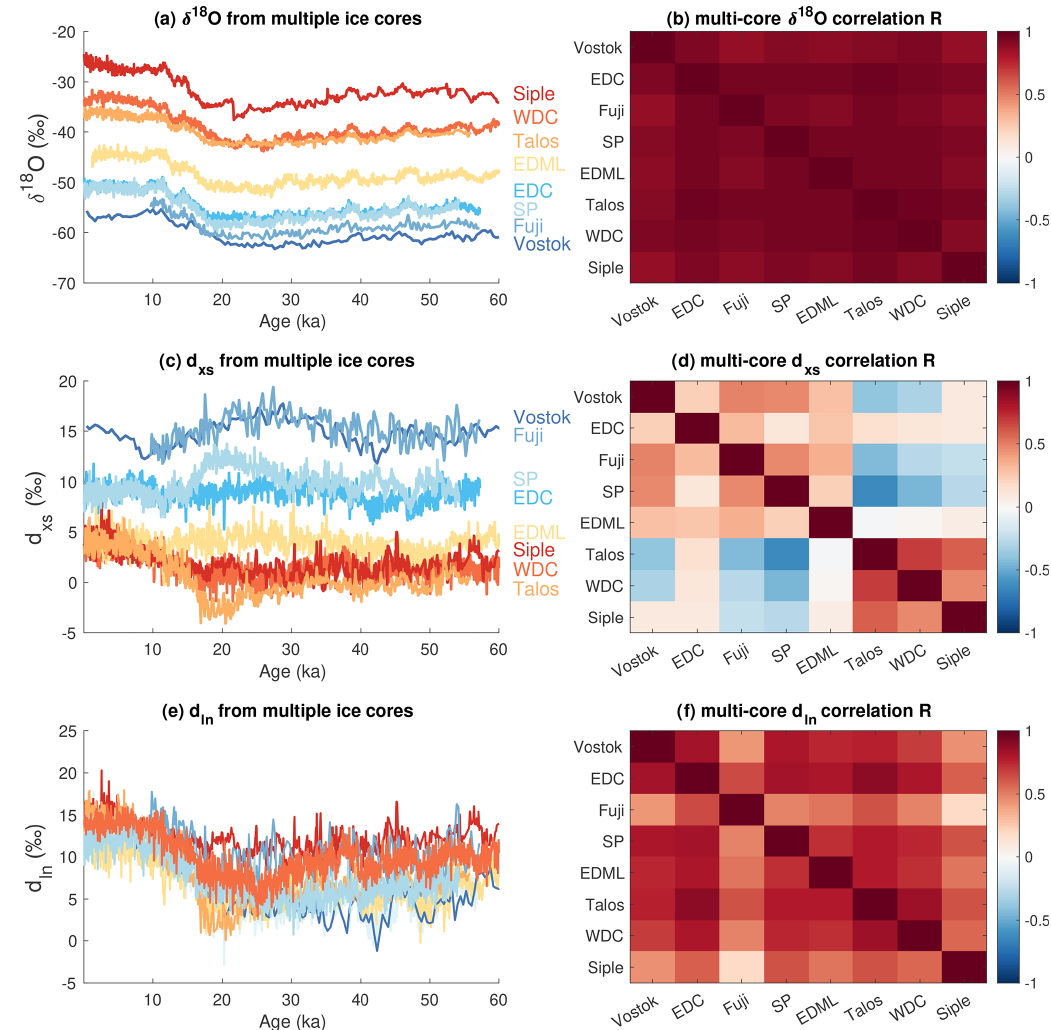
Figure 6. Time series and cross-correlation matrices for eight different deep Antarctic ice-core sites. (a, b) δ 18 O; (c, d) d xs ; and (e, f) d ln . In the time series plots, each record is colored by its Holocene average δ 18 O value. See Sect. 4.2 in the text for details and references for the ice-core records. All original records are interpolated to even 50-year time spacing on the Buizert et al. (2018) synchronized timescale where possible, or they are plotted on original published timescales. All records are ordered by their approximate modern surface temperature in the cross-correlation